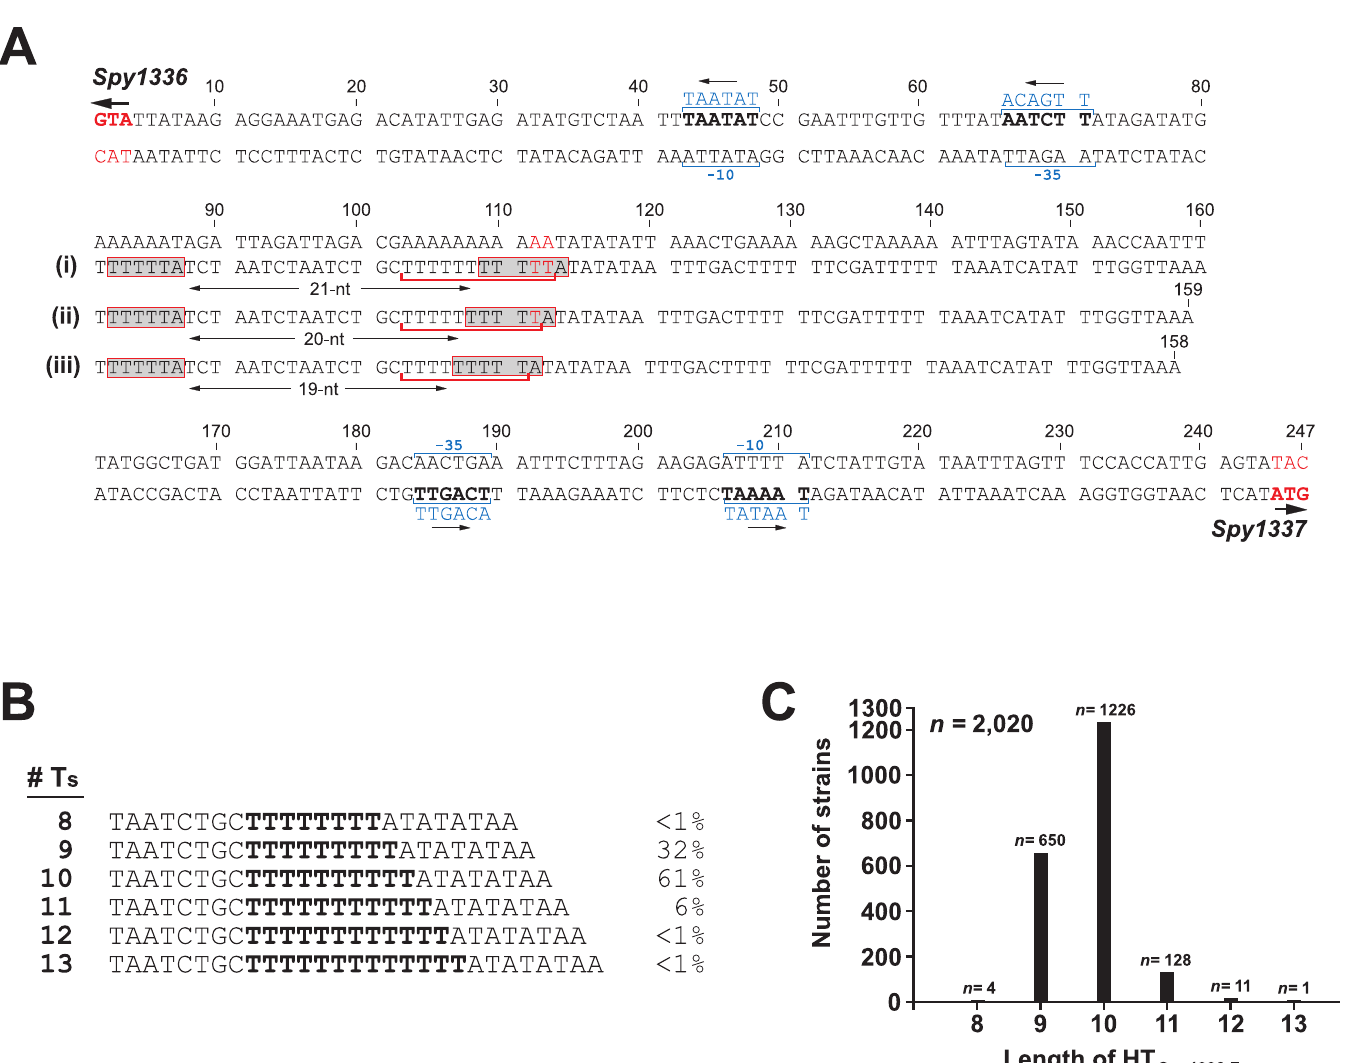
Fig 2. Heterogeneity in the homopolymeric tract located between Spy1336/R28 and Spy1337 . (A) Spy1336/R28-Spy1337 regulatory region from the reference strain MGAS6180 [31]. (i), (ii), and (iii) refer to HT Spy1336-7 containing 11, 10, or 9 T nucleotides, respectively, and the change in the spacing between two ATTTTT (shaded) direct repeats. The HT variants are underlined in red. Inferred promoters are shown. (B) DNA sequence of the prevalent HT Spy1336-7 nucleotide. Numbers at right refer to percent of all isolates analyzed with the designated number of Ts. (C) Frequency distribution of the most common HT Spy1336-7 alleles in the emm28 population. HT containing between 8 and 13 T nucleotides are shown with the corresponding number of strains ( n ) in which they are present. The Spy1336-7 total number of strains represented is 2,020.